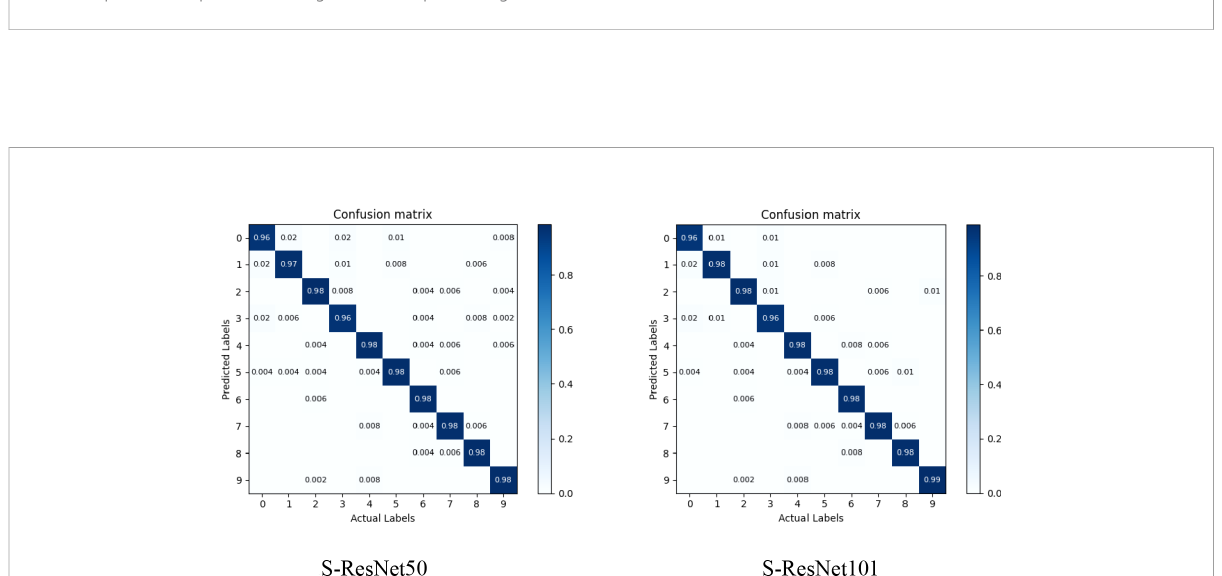
FIGURE 13 Confusion matrix for the identi fi cation results of 10 classes of small insect targets. Aphid (0), Red Spider (1), Locust (2), Sweet potato White fl y (3), Rice Leaf Roller (4), Asian Rice Borer (5), Corn Borer (6), Land Tiger (7), Bollworm (8), and Cluster Caterpillar (9).